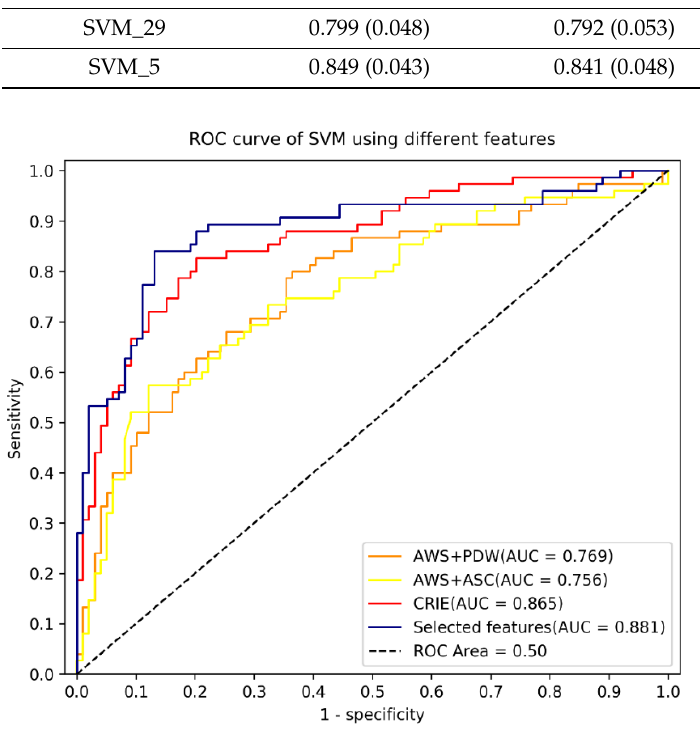
Figure 1. Area under receiver operating characteristic of SVM with different features.